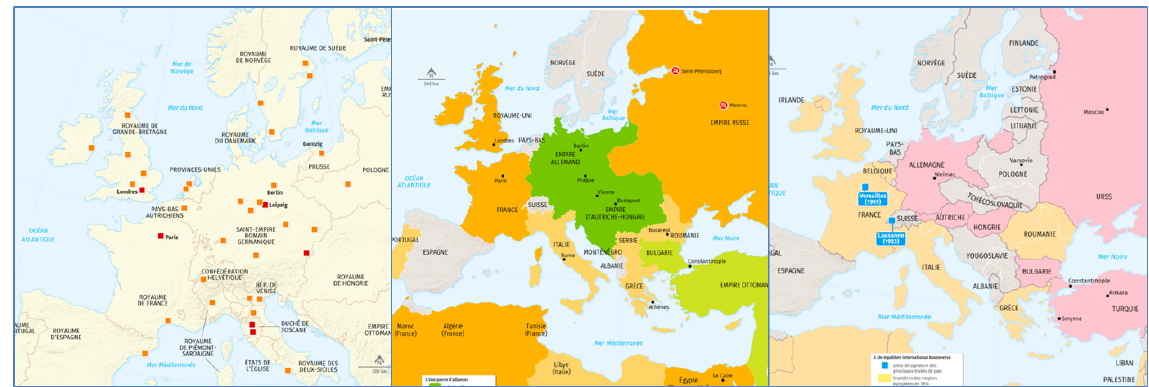
Figure 10: Three maps of Europe at different periods of time for history classes: the country borders are not the same.